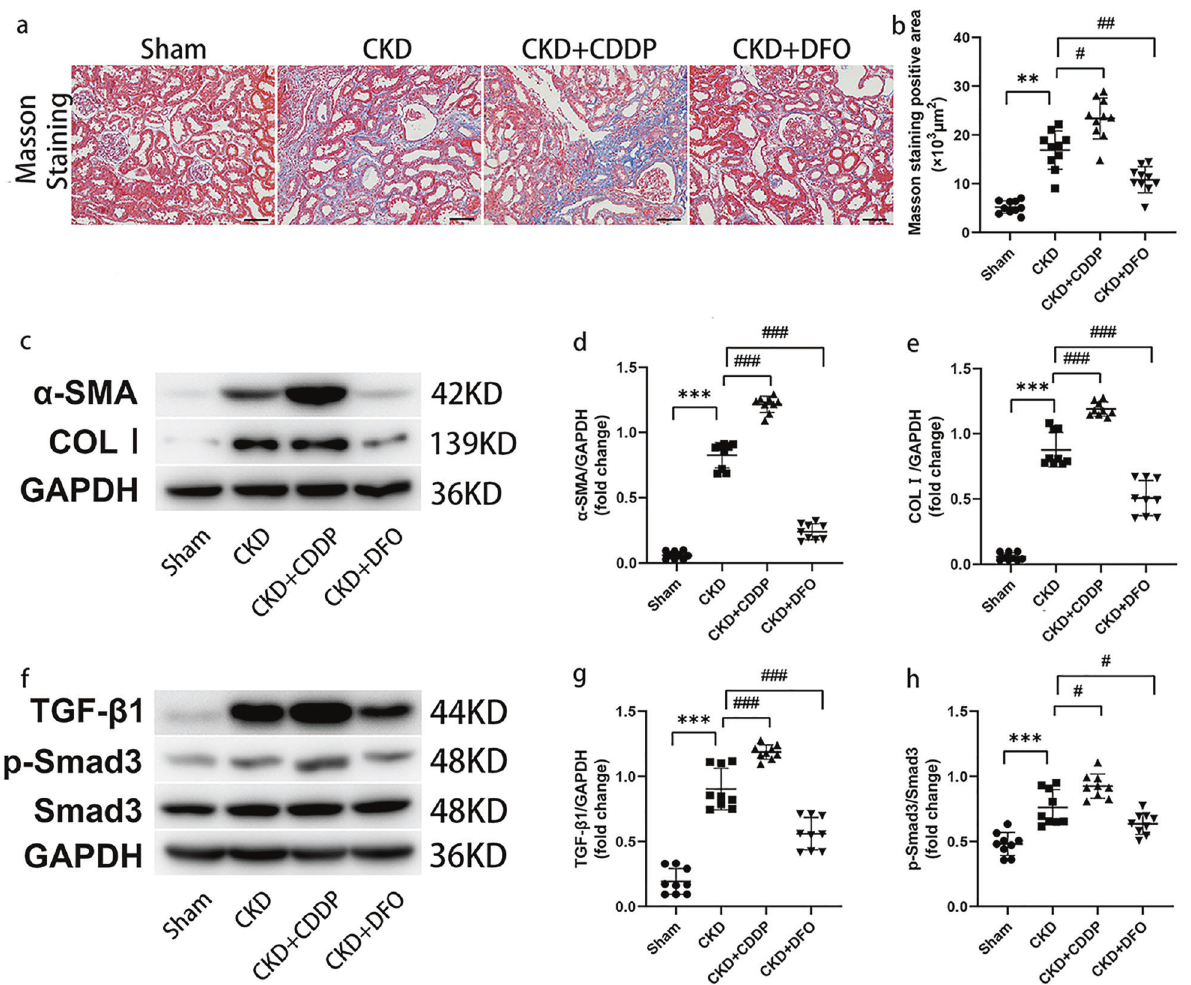
Fig. 6 Ferroptosis is a potential therapeutic target in renal fi brosis. CDDP and DFO affect fi brosis progression ( a , b ) and ECM deposition ( c – e ) in CKD rats by regulating the TGF- β 1/Smad3 signaling pathway ( f – h ). ** P < 0.01, *** P < 0.001 vs. Sham group; # P < 0.05, ## P < 0.01, ### P < 0.001 vs. CKD group. Scale bar = 50 μ